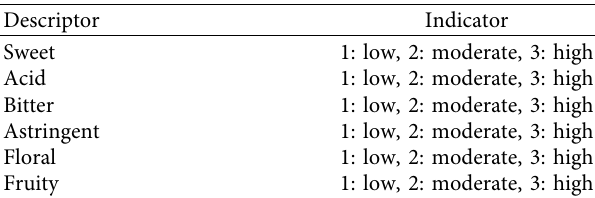
Table 3: Organoleptic descriptors of fine-flavor native